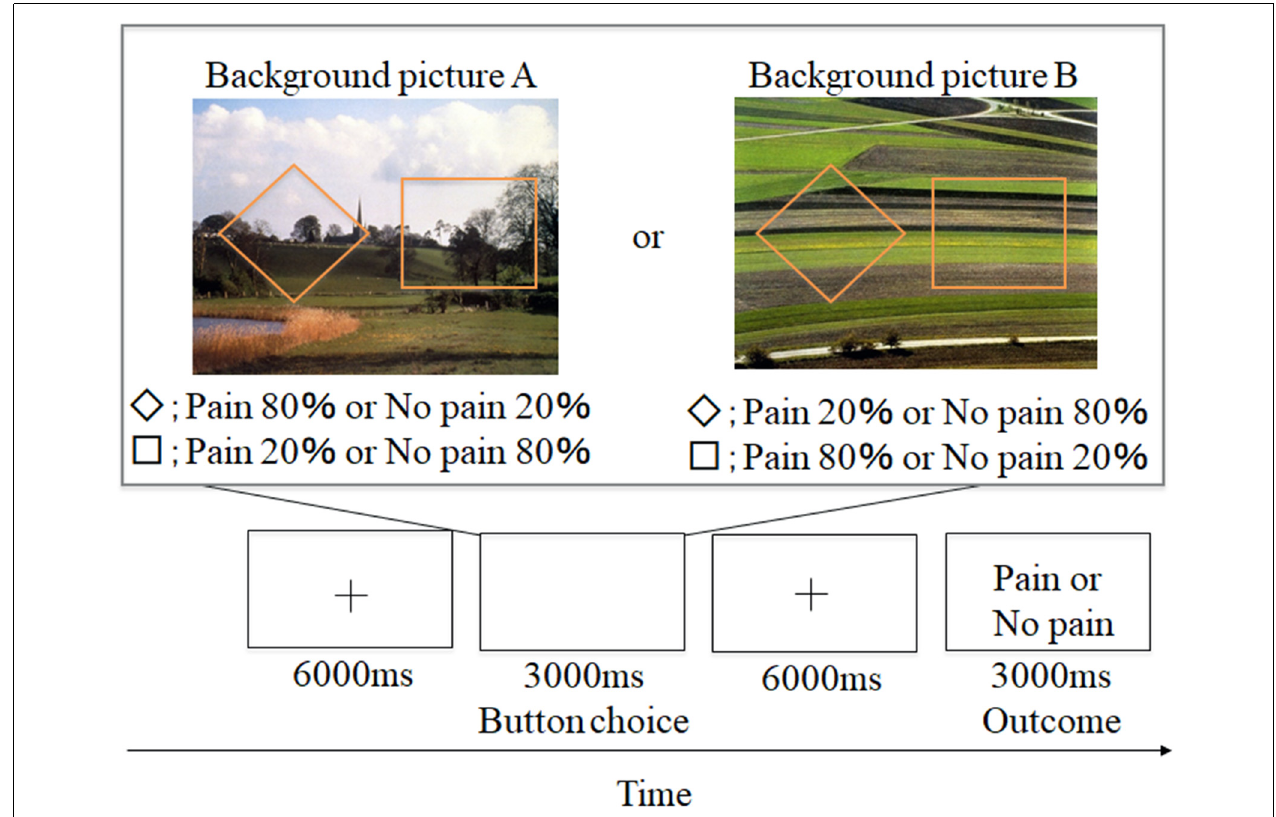
FIGURE 1 | Example of aversive-based trials in the contextual learning task. A total of 60 trials was conducted. + grid